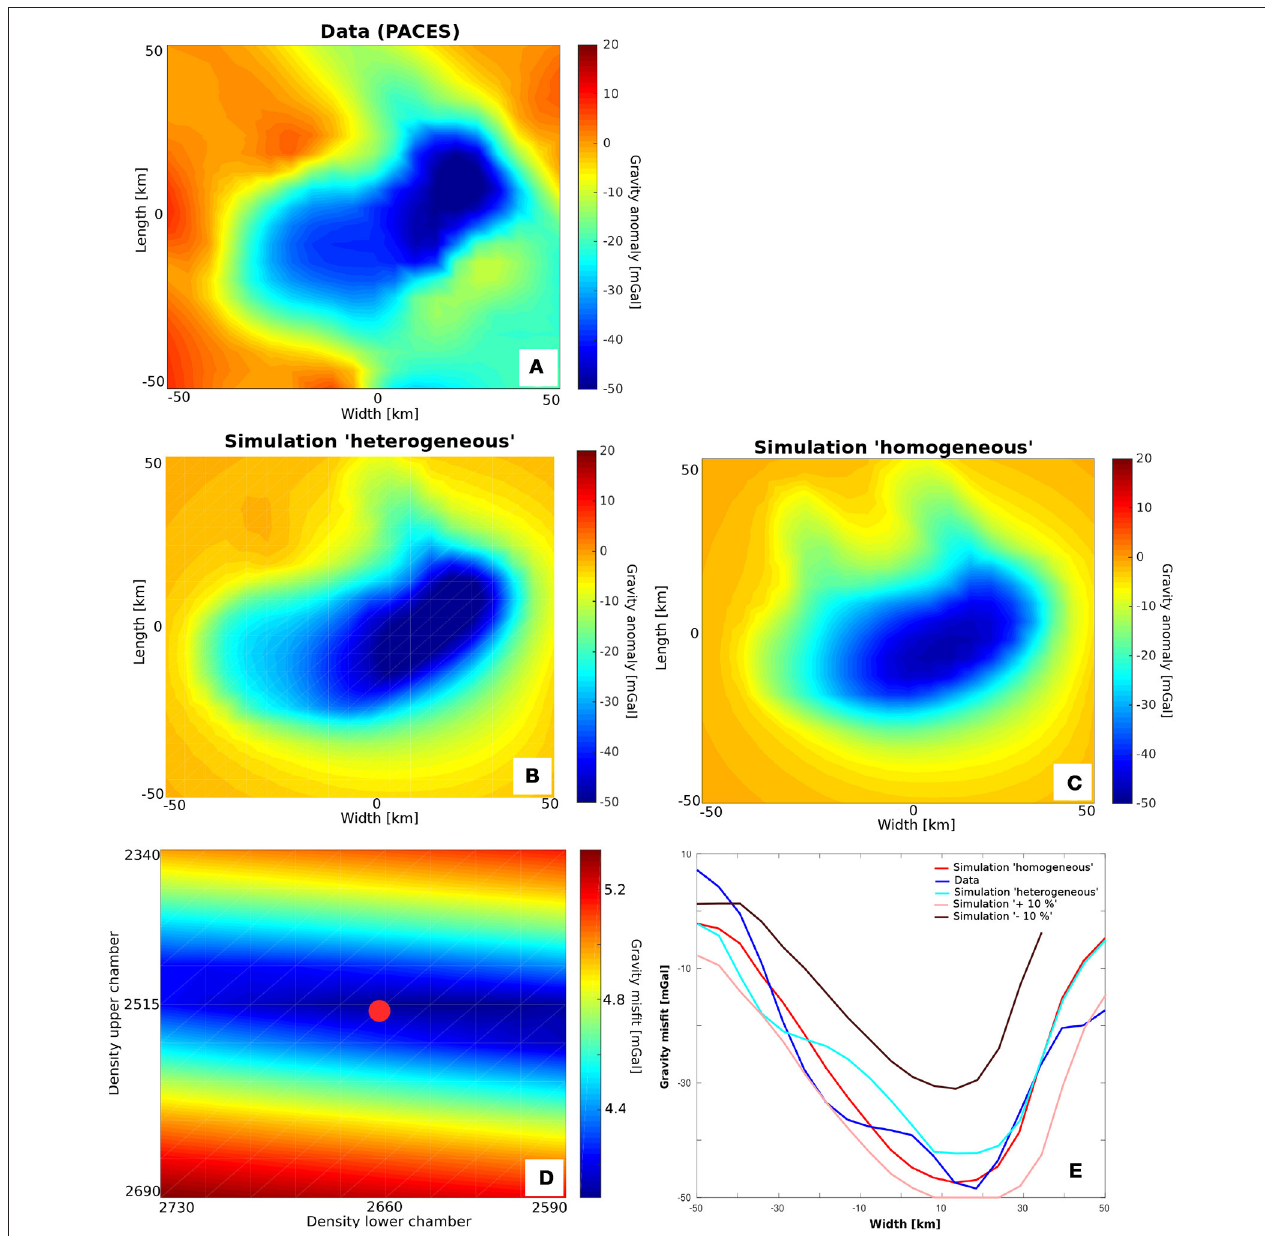
FIGURE 4 | Result of the gravity inversion. (A) Observed gravity anomaly data from PACES. (B) Best manual fit assuming heterogeneous magma reservoir densities. (C) Best fit model by grid search inversion, keeping the density of the reservoirs homogeneous. (D) Misfit function in the grid search inversion. The color represents the least square misfit between the simulation and data, with blue colors indicating a good fit to the data. (E) Gravity anomaly comparison between simulation result and data at a representative 1D line across the surface (along length = 0